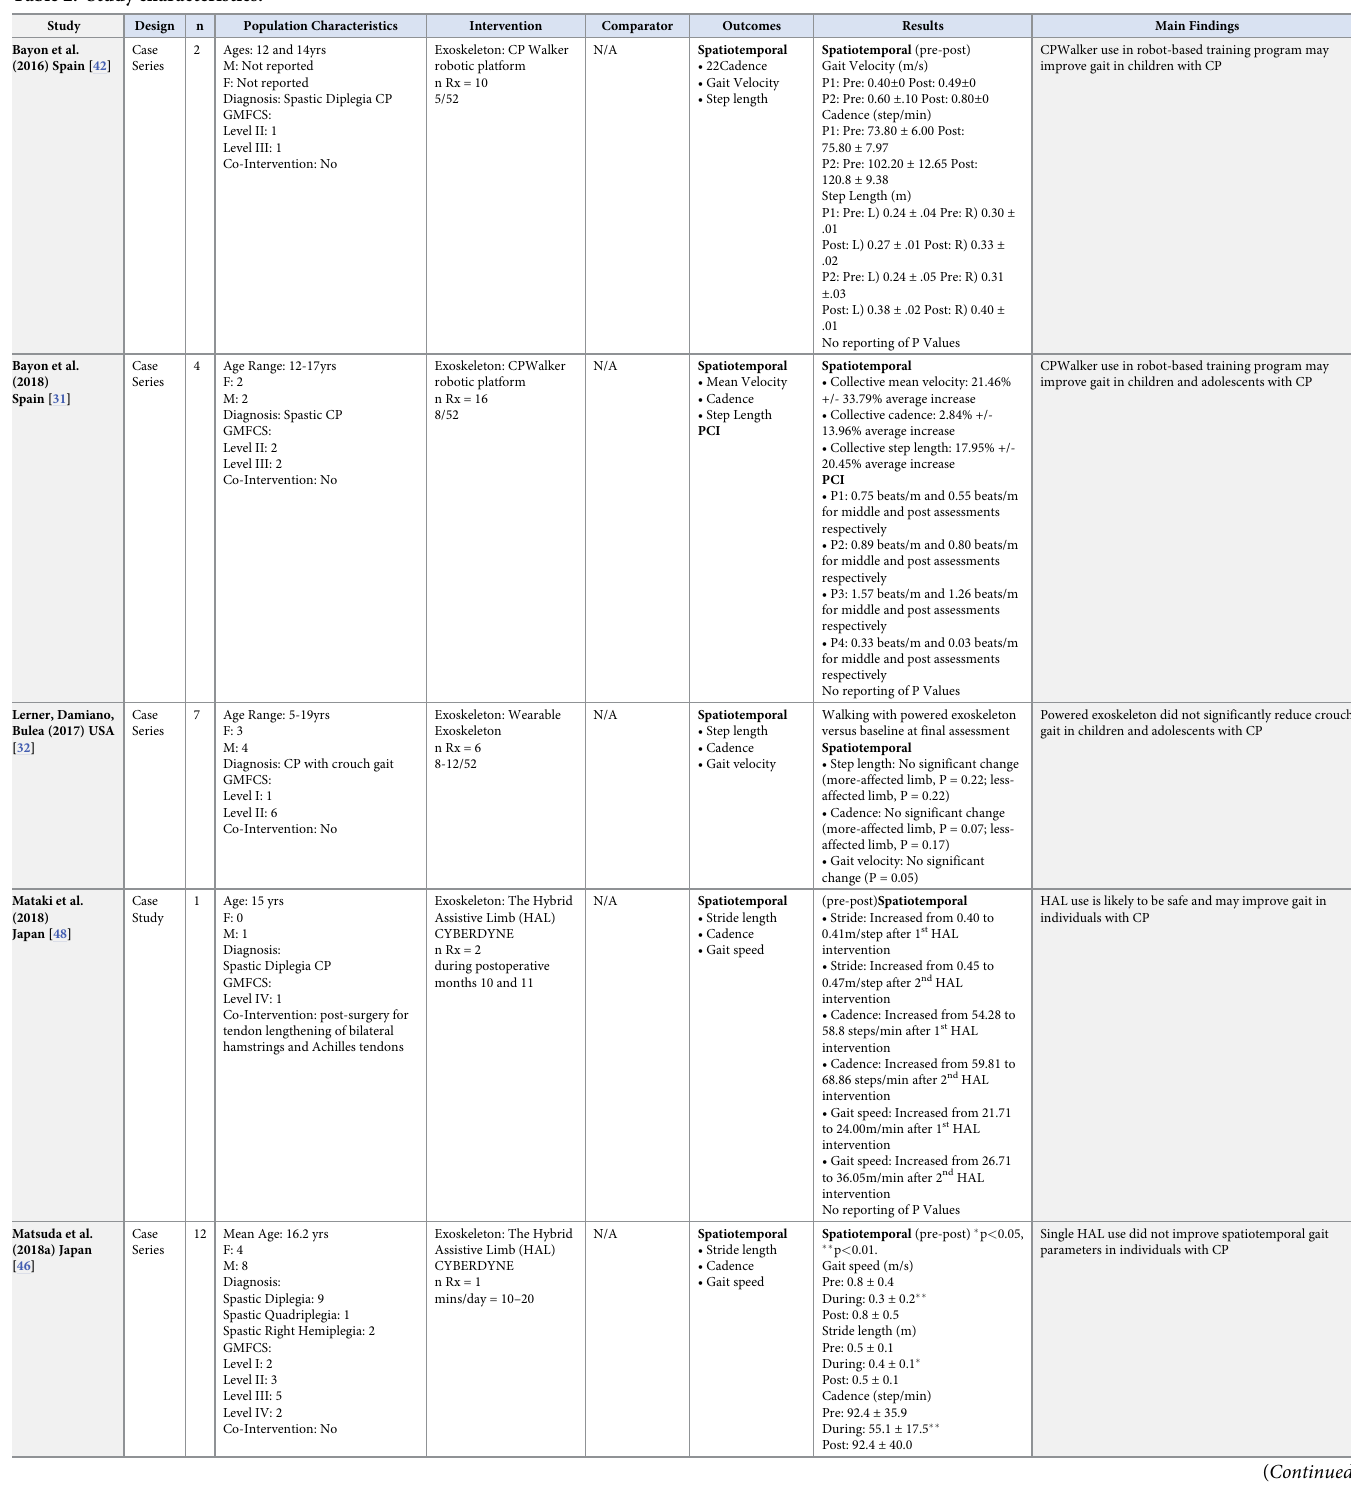
Table 2. Study characteristics.